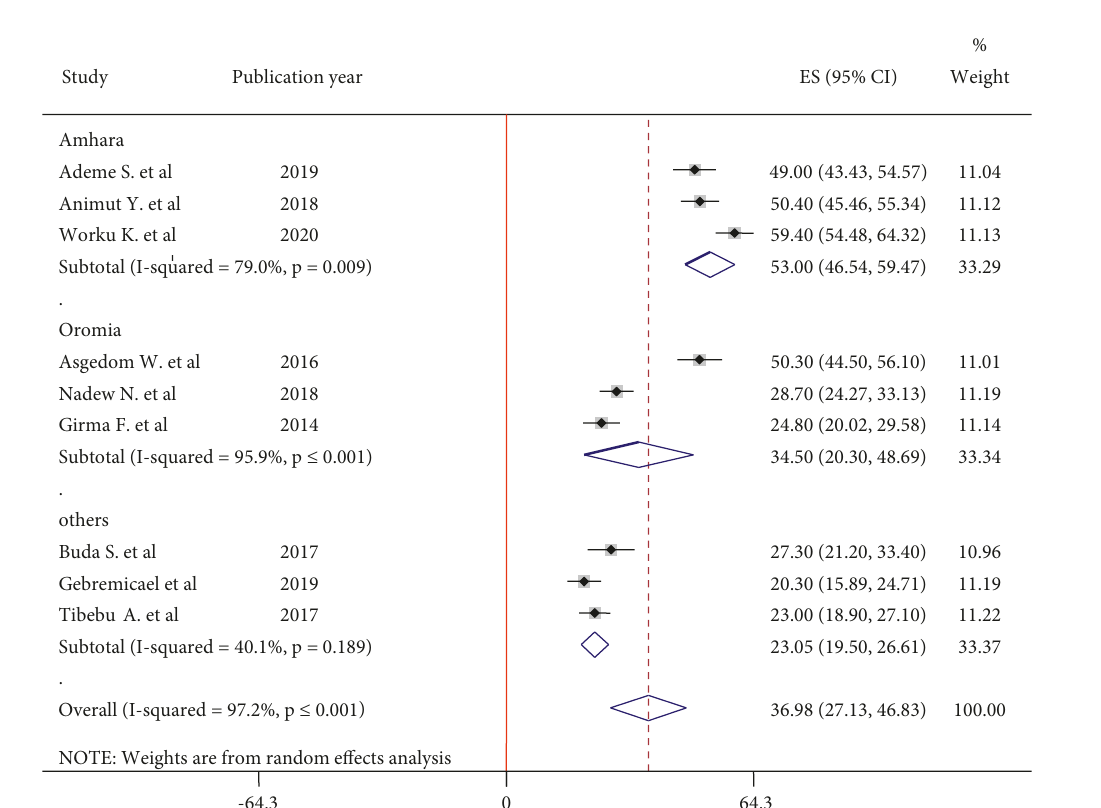
Figure 3: Subgroup analysis by region for self-care adherence of hypertensive patients in Ethiopia,